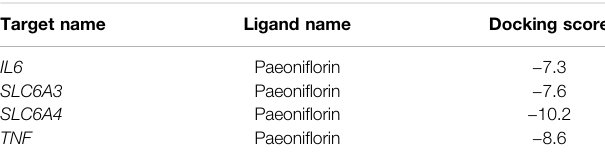
TABLE 3 | Molecular docking score